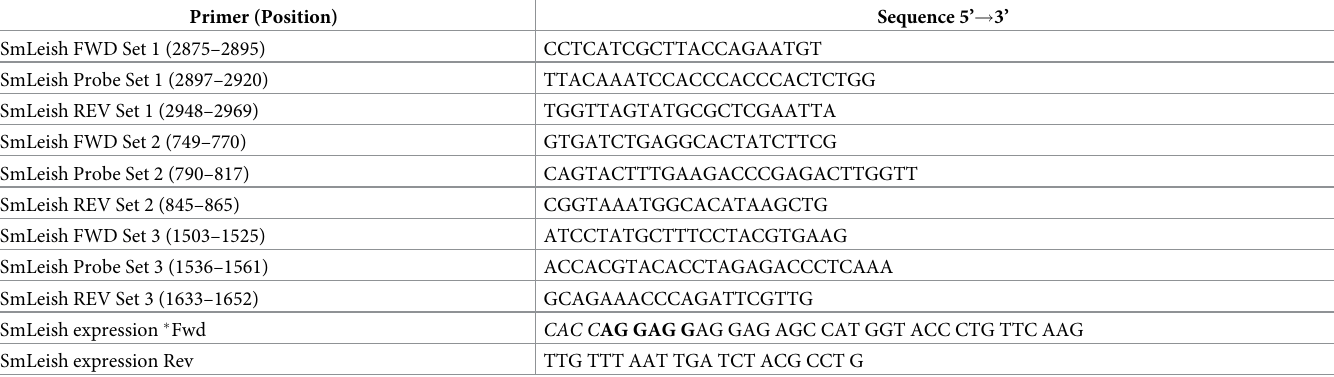
Table 1. Primers and probe used in this